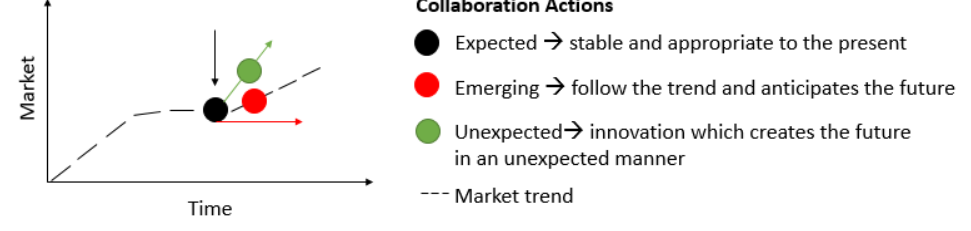
Figure 6. Collaborative action types regarding time